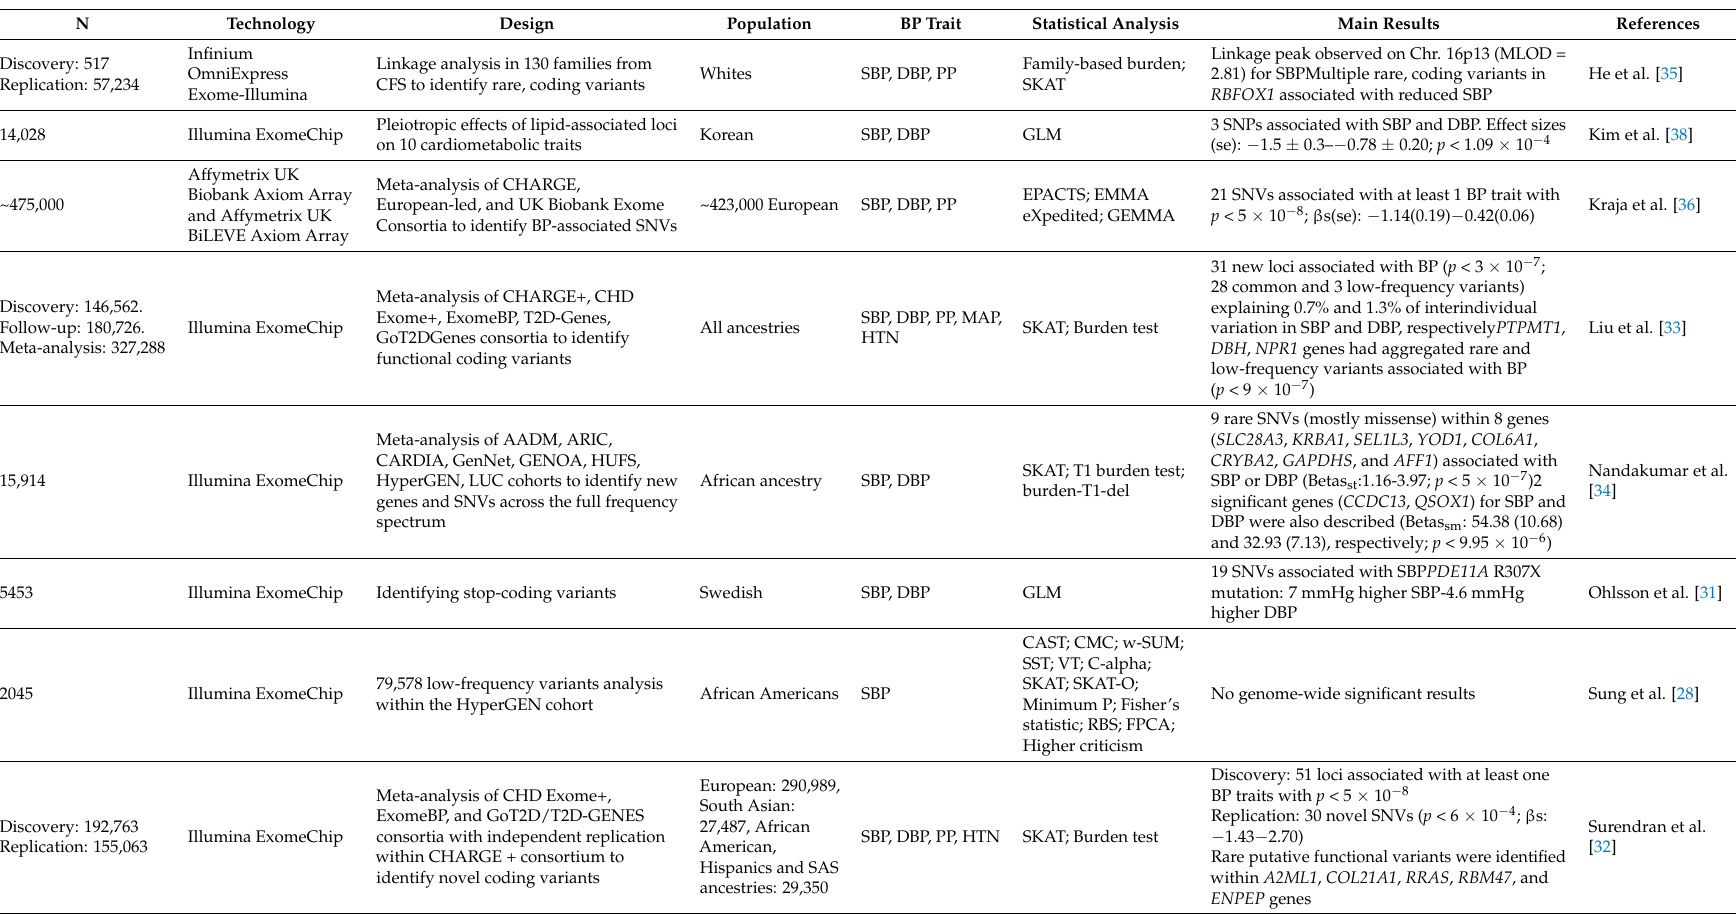
Table 1. Results from Exome Chips-Based